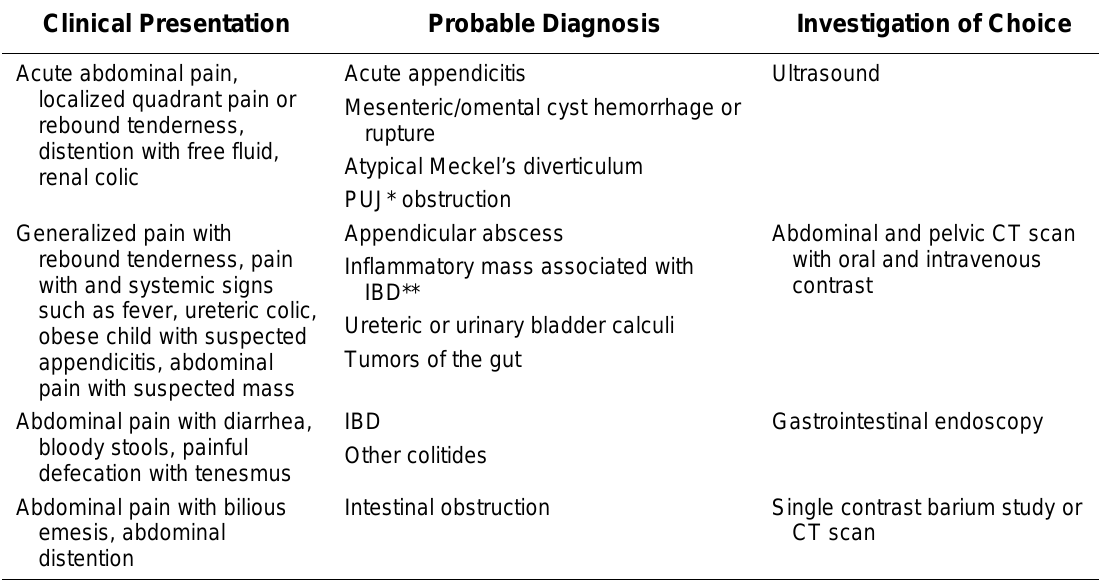
Clinical Guide to Choosing Appropriate Test: Imaging Study or Gastrointestinal